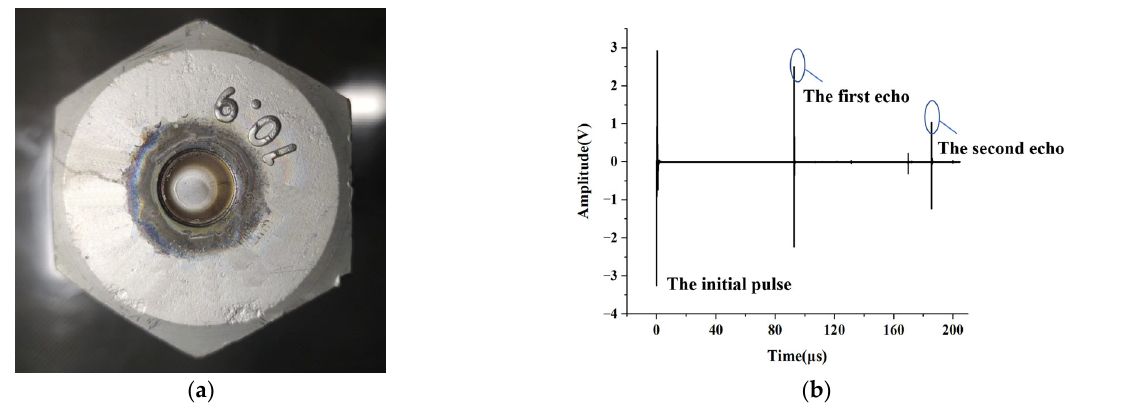
Figure 4. ( a ) M42 wind turbine tower bolt with piezoelectric film sensor. ( b ) Film sensor echo signal.